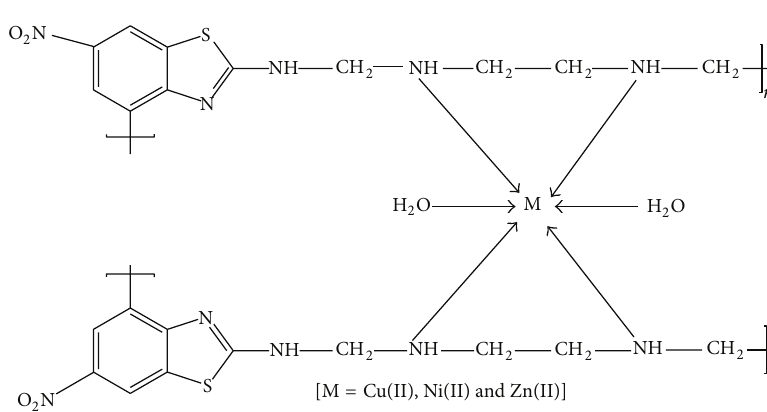
Figure 6: Proposed geometry of BEF metal complexes.